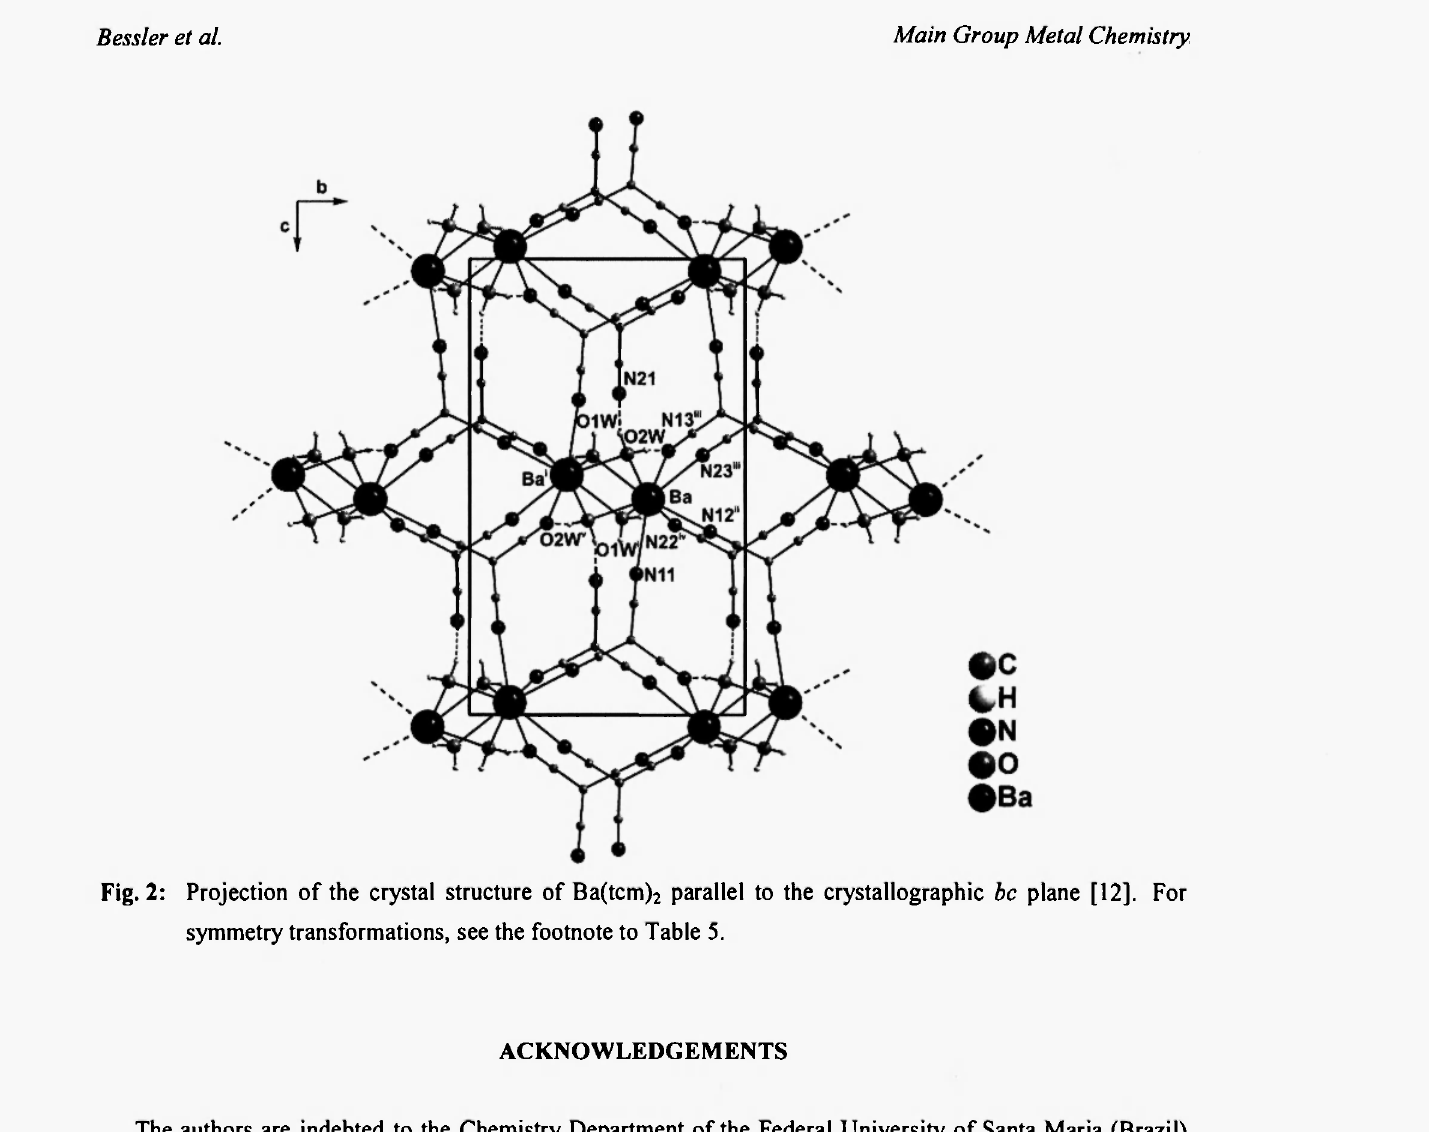
Fig. 2: Projection of the crystal structure of Ba(tcm) 2 parallel to the crystallographic be plane [12]. For symmetry transformations, see the footnote to Table